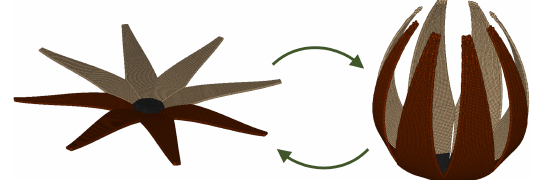
Fig. 3: A single polyp’s pulsation cycle. The coral moves from its relaxed state to an actively contracted state and then relaxes back to its orig- inal, open, resting state. The two tentacle colors were chosen to differentiate the tentacles in the foreground and background.